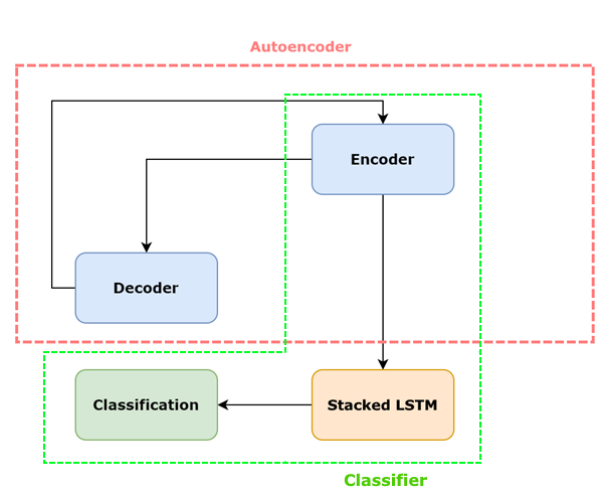
Figure 15. Model architecture of the hybrid model. The red container contains components of the previous autoencoder approach. The green components indicate the new hybrid model which acts as a